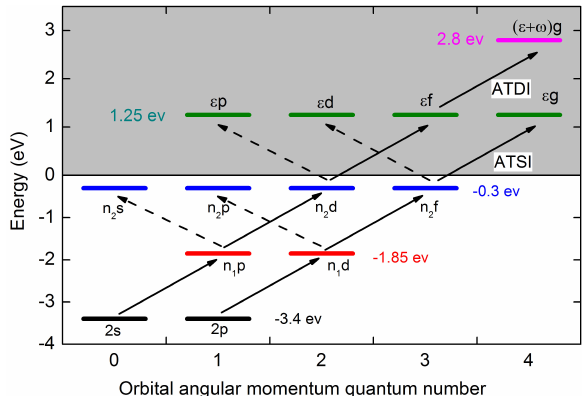
Figure 6. (Color online) Schematic of the resonance coupling between the L -shell electrons and a series of Rydberg states or free electrons. Each diagonal arrow represents a photon absorption of approximately ¯ h ω = 1.55 eV in energy. Two possible quantum paths are shown to produce free electrons by photon absorption.